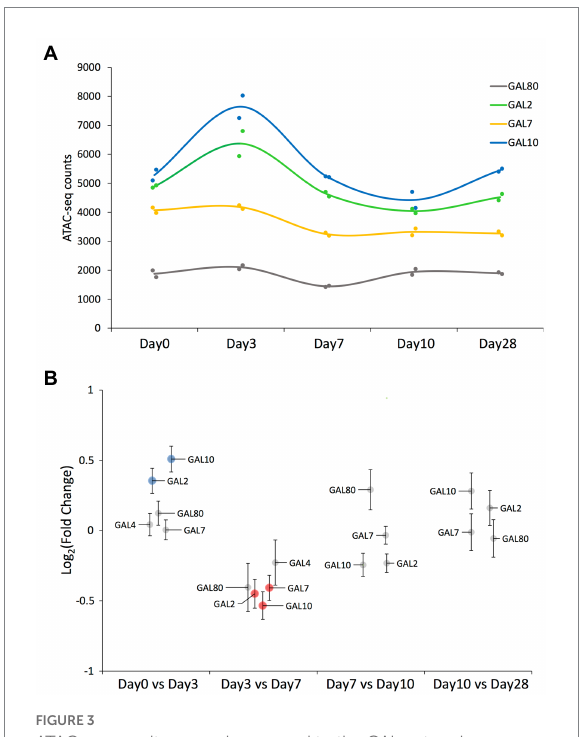
FIGURE 3 ATAC-seq results on peaks mapped to the GAL network genes. (A) ATAC-seq peak value of those peaks mapping to the GAL network genes that have been detected across all time points. Solid circles represent the values corresponding to each replicate, while the smooth line represents the average value at each time point. Each gene’s common name is indicated in the figure panel. (B) Swarm plot showing the log 2 -fold change on each of the ATAC-seq peaks mapping to the GAL network genes, comparing samples of consecutive time points. Each peak’s associated gene is indicated by a label (note that GAL4’s associated peak was not detected in the last two time points). Significantly differential peaks ( p adj < 0.05) are plotted either in blue (if increased in the latter time point) or in red (if increased in the former time